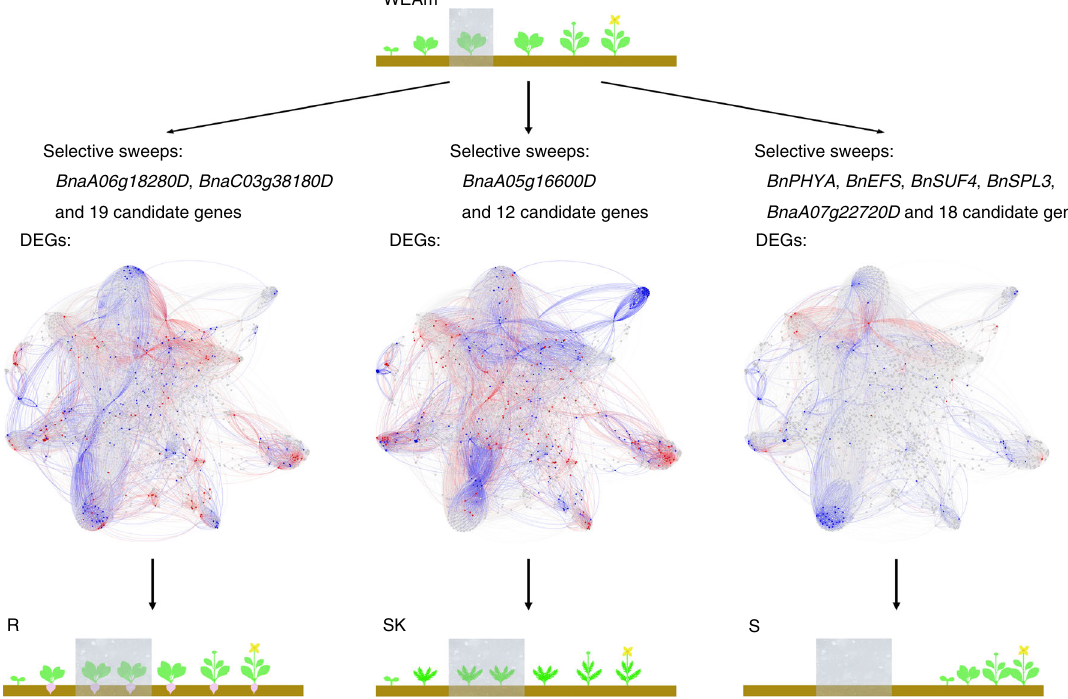
Fig. 5 Different diversi fi cation processes of B. napus . Plant cartoons were modi fi ed from Schiessl et al. (2017) 43 and show the growth cycle of different B. napus , the grey rectangle indicates winter (vernalization). The networks represent biochemical reactions that are catalyzed by enzymes (three middle panels); the colors of the nodes (reactions) in the metabolic networks represent the difference in expression of the B. napus genes that are orthologs to the A. thaliana genes encoding the enzymes for these reactions. Red: overexpressed comparing to WEAm; Blue: underexpressed comparing to WEAm; Grey: no unique DEGs detected. WEAm: Winter rapeseed in Europe and America, S: spring rapeseed, SK: Siberian kale, R: